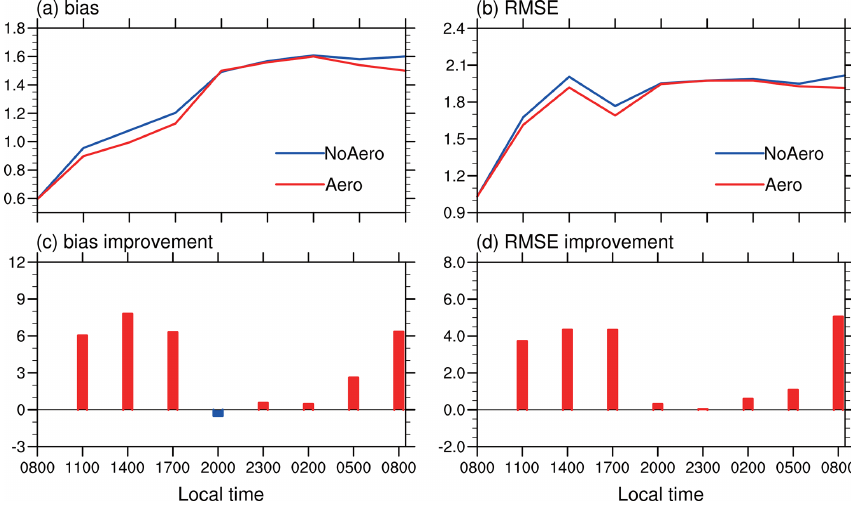
Figure 17. Same as Fig. 12, but for wind speed at 10m (ms − 1